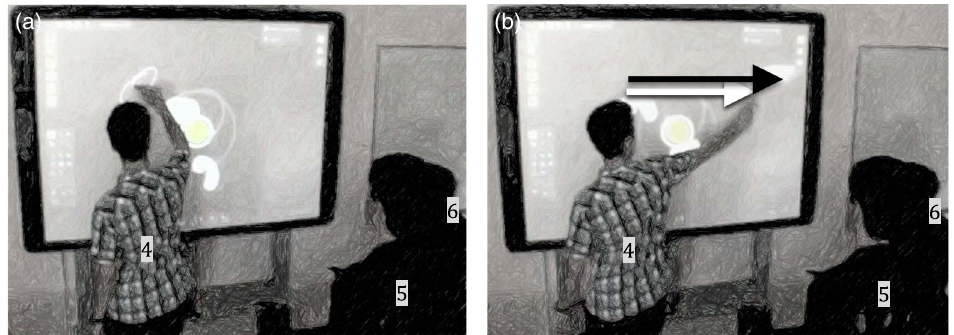
FIG. 11. Student 4 turns to the IWB, quickly draws a new planet, grabs it, and throws it with a very large velocity towards the right- hand side of the